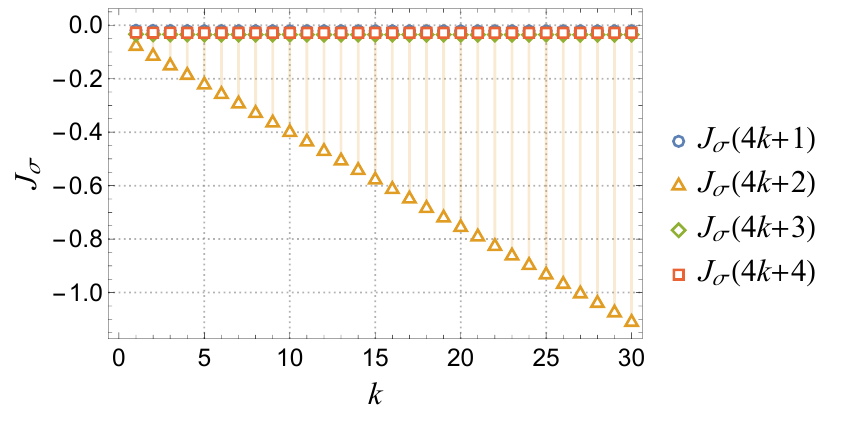
Figure 3 . Numerical result of the integral (6.35) for twist